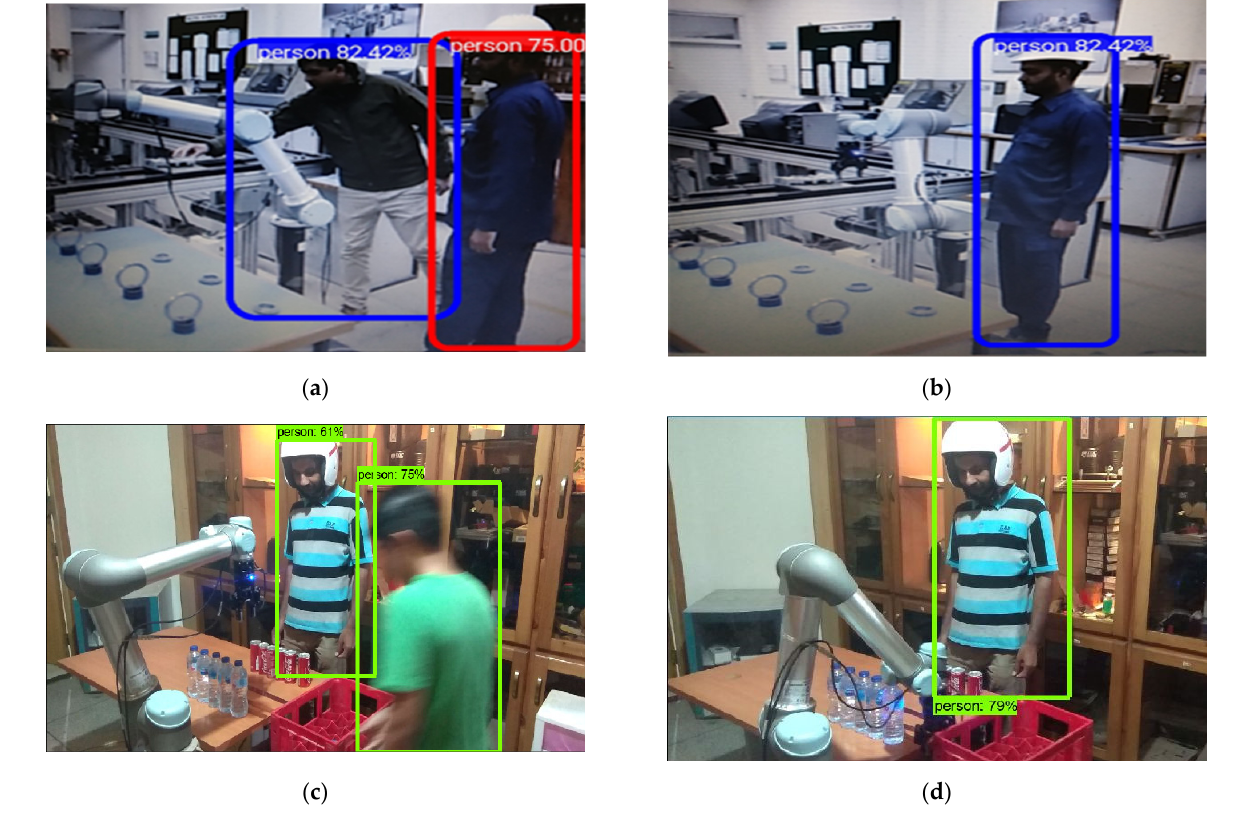
Figure 8. ( a ) Detection of unidentified person and displaced case; ( b ) Case being aligned by the cobot; ( c ) Detection of unidentified person and displaced crate; ( d ) Crate being aligned by the cobot. each iteration are shown. The maximum time taken to decide on a single situation was noted as 0.03 s. The time taken for decision for handling situations for two of the cycles in one test run is shown in Figure 9. Anxieties, total anxiety, and the maximum anxiety situation for